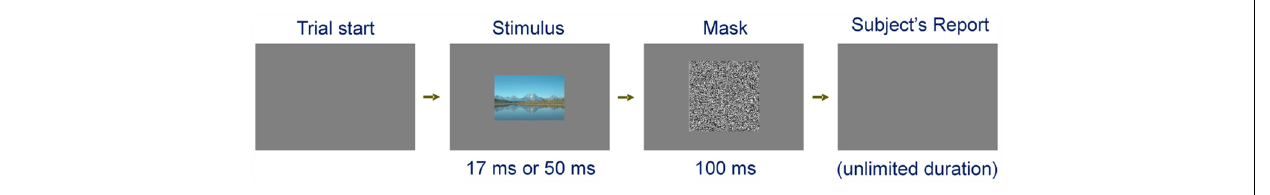
FIGURE 2 |Trial paradigm used in our implementation of Step 1. Each trial started when the subject indicated readiness.The visual stimulus (a real-world image) was presented for 17 ms or 50 ms, depending on the trial.To minimize the contribution of stimulus repetition on the subject’s